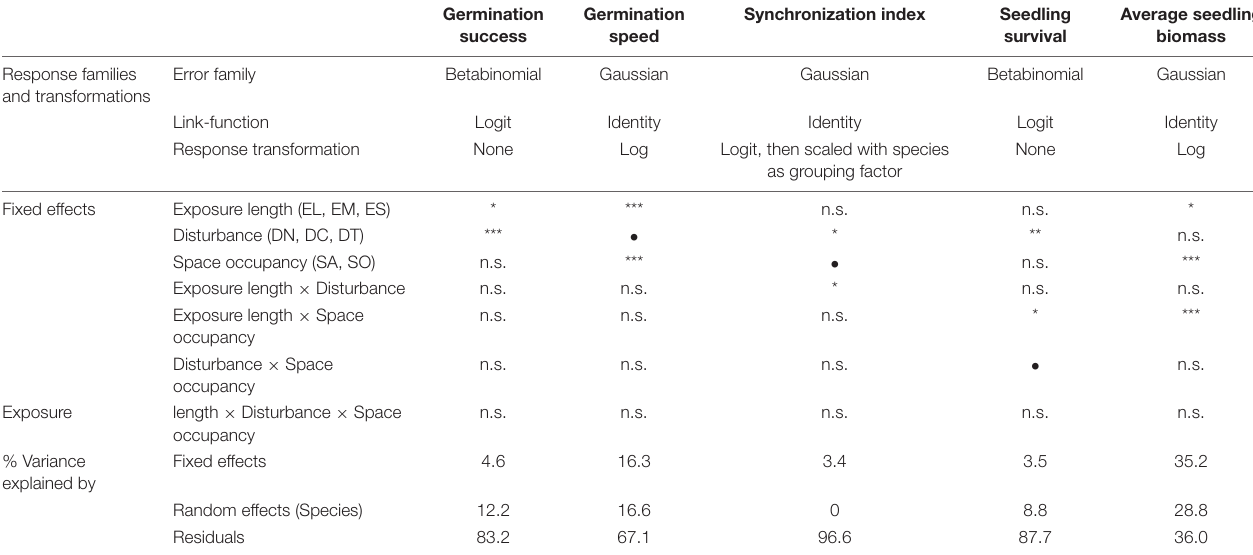
TABLE 2 | Overview of the structure and the results from the Generalized Linear Mixed Effects Models for early life performance